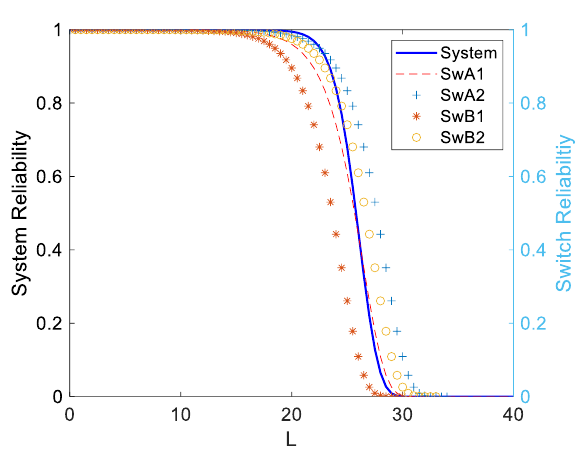
Figure 7. Set 1 in Table 6 ( L SwA10 =3 , L SwA20 =1 , L SwB10 =5 , L SwB20 =2 , and α i = 0.5).